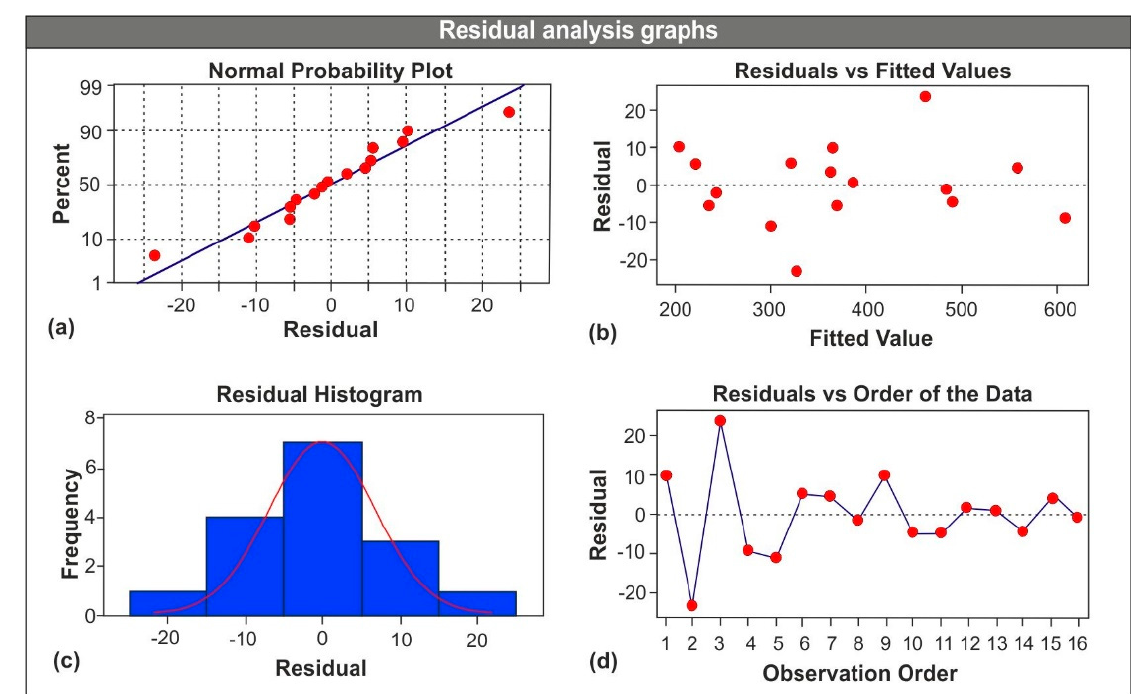
Figure 5. Residual analysis graphs: ( a ) Probability plot, ( b ) residuals vs. fitted values, ( c ) residual histogram, and ( d ) residuals vs. order.